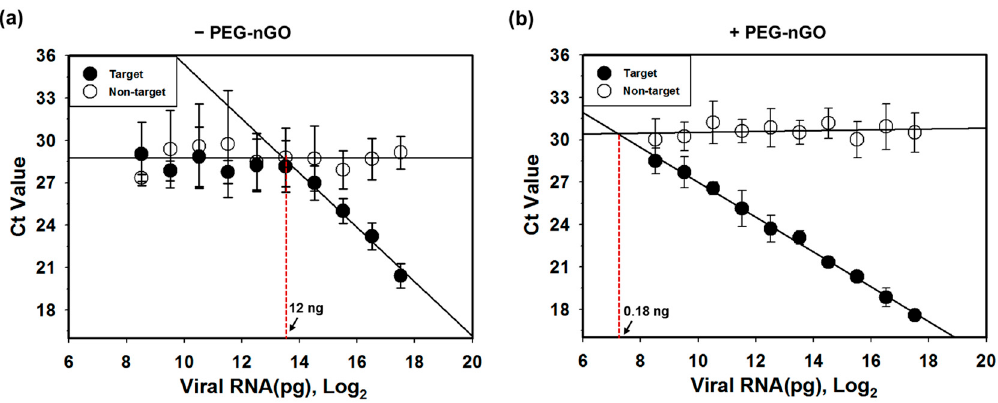
Figure 5. Effect of PEG-nGO on sensitivity of EG-based qPCR. ( a ) Comparison of Ct values of qPCR-amplified products with serially diluted (188 ng to 0.37 ng) target (IFZ B) and non-target (IFZ A) RNA in the absence of PEG-nGO. Red dotted line represents the concentration below which it was difficult to discriminate between target RNA and non-target RNA. ( b ) Comparison of Ct values of qPCR-amplified products with serially diluted (188 ng to 0.37 ng) target and non-target RNA in the presence of PEG-nGO. Red dotted line represents the concentration up to which target and non-target can be distinguished.